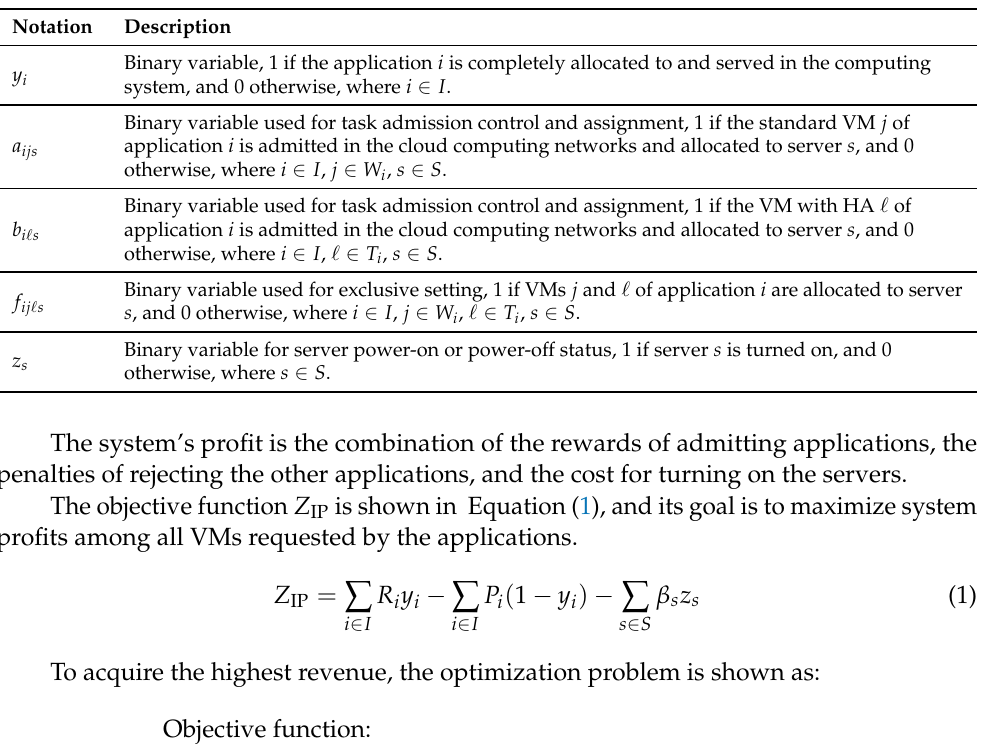
Table 5. Decision